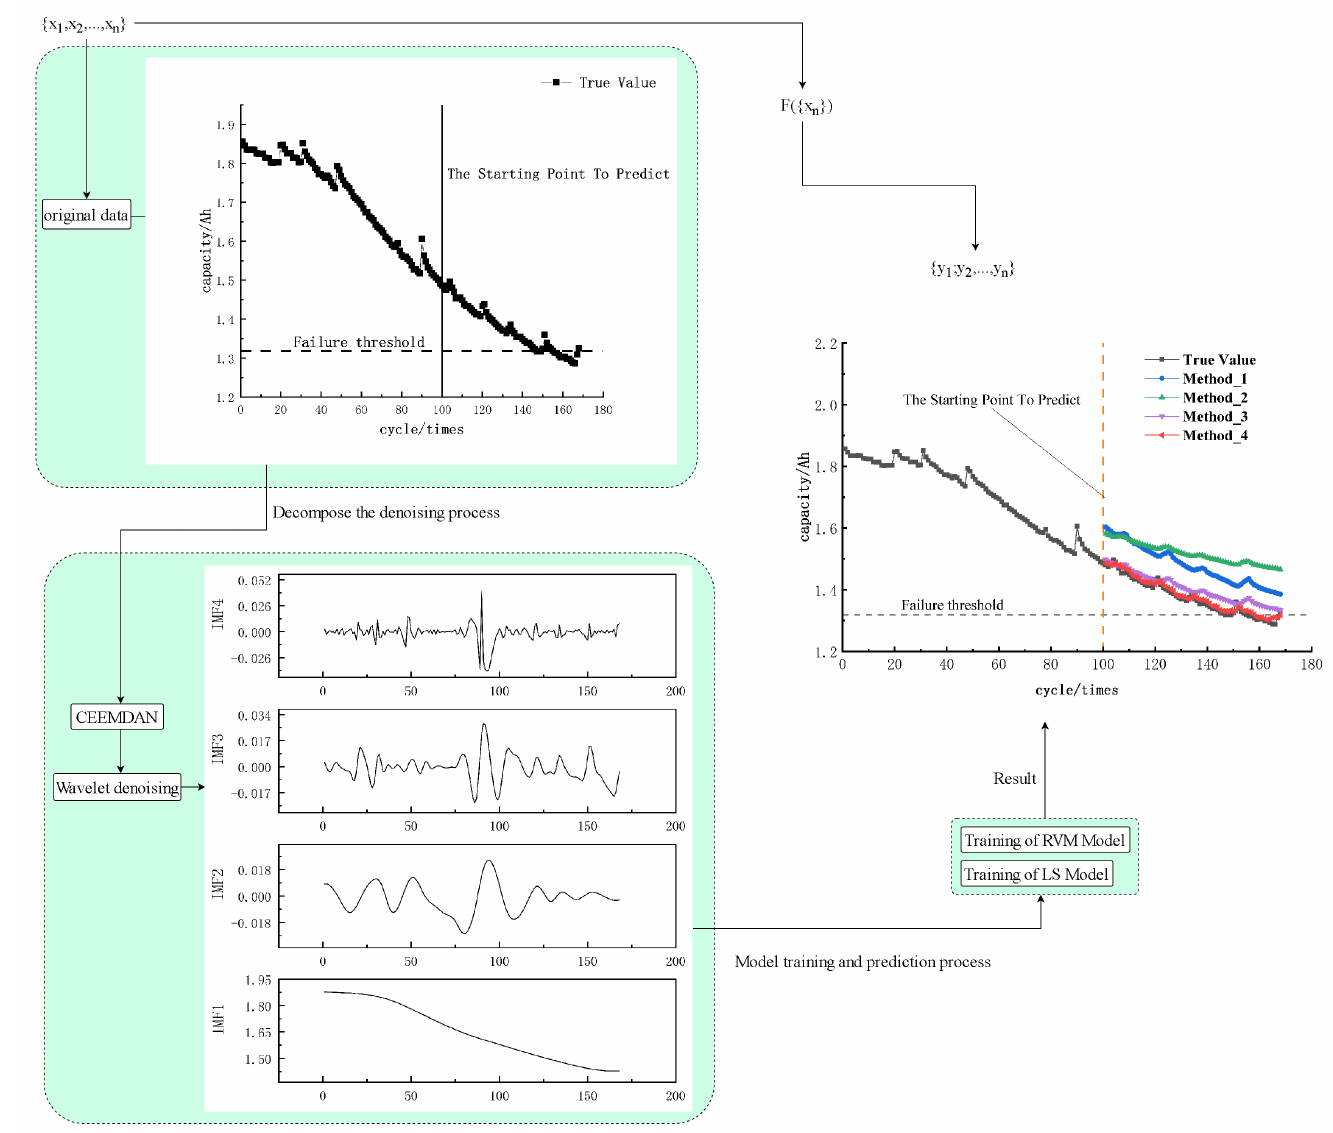
Figure 4. The overall